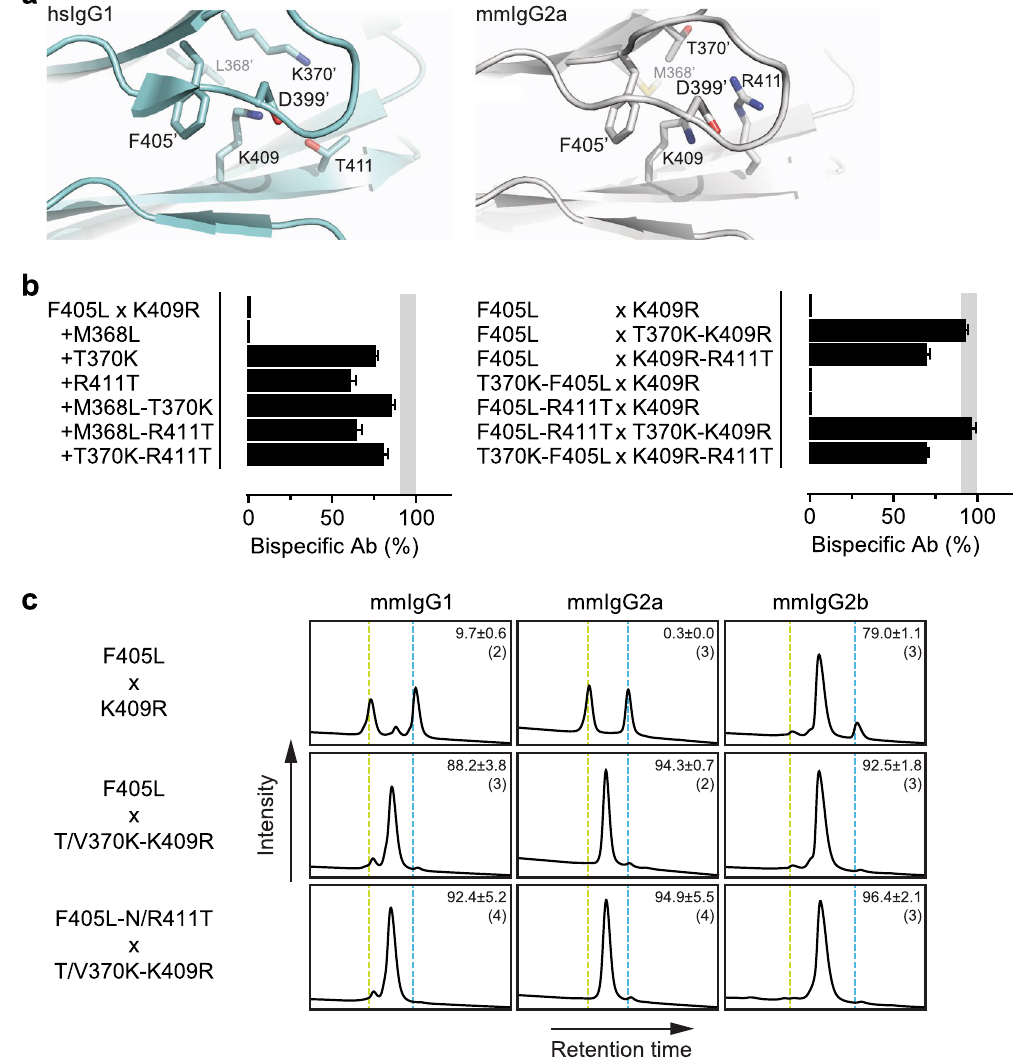
Figure 2. ( a ) Amino acid residues surrounding K409 at the CH3-CH3 interface of hsIgG1 (left panel) and mmIgG2a (right panel). Images were generated from PDB IDs 3AVE 54 (hsIgG1) and 1IGT 61 (mmIgG2a) using PyMOL software (Schrödinger). ‘Indicates residues on opposite CH3 domain. ( b ) Efficiency of cFAE as measured by HIC of symmetric (left panel) and asymmetric (right panel) mixtures of 2F8- and 7D8-derived chimeric parental antibodies. The chimeric parental antibodies contained human variable regions and human IgG1 constant regions, wherein only the CH3 domain was swapped with that of mouse IgG2a and containing the indicated point mutations. Data represent mean ± SEM of at least two separate experiments. Shaded area represents 90–100% efficiency. ( c ) Exemplary Hydrophobic Interaction Chromatography (HIC) profiles of bispecific antibodies generated by cFAE using combinations of 2F8- and 7D8-derived chimeric parental antibodies. The chimeric parental antibodies contained human variable regions and mouse constant regions that contained the indicated point mutations (above and left of panels, respectively). Numbers represent mean ± SEM (n) percentage of bispecific antibody product (middle peaks). Vertical lines correspond with the retention times of the individual 2F8 (green) and 7D8-derived (blue) parental